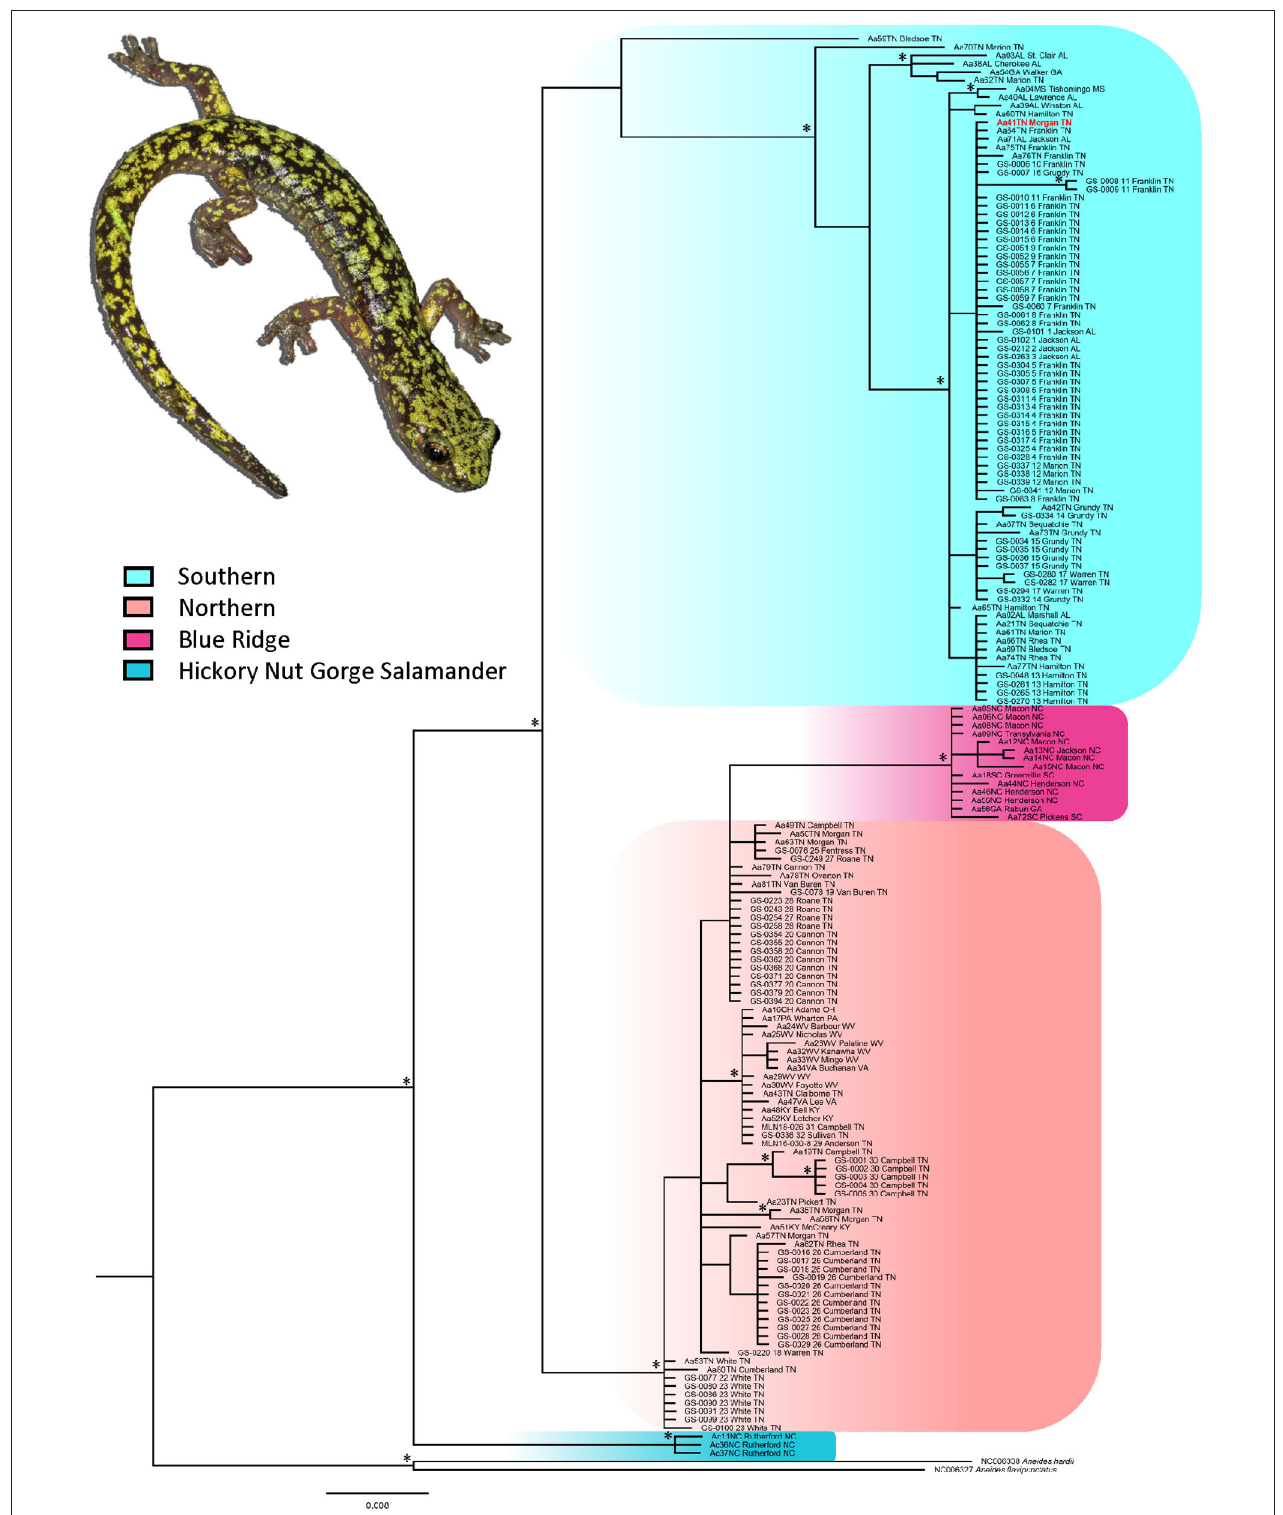
FIGURE 2 | Bayesian phylogram for the mitochondrial cytb dataset including data from Patton et al. (2019). Major lineages are highlighted. Nodes with posterior probabilities > 0.95 are indicated with an asterisk. Site labels and GenBank accession numbers correspond to those in Table 1 ; Supplementary Table S1 .